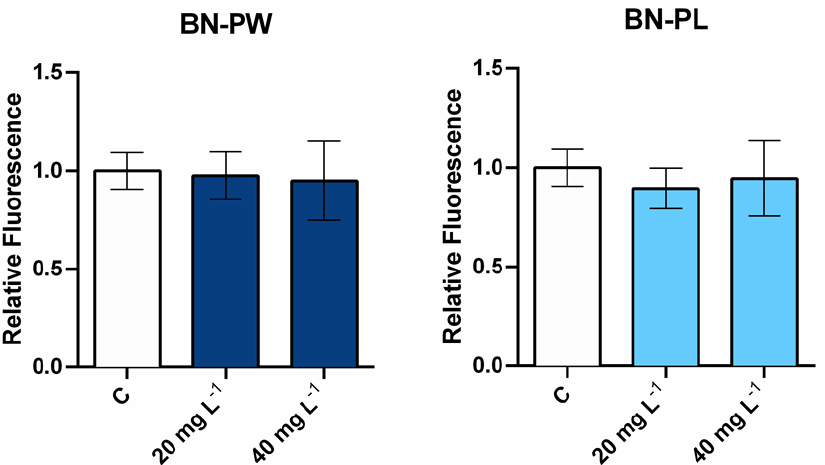
Figure 7. Determination of reactive oxygen species (ROS) levels in A549 cells exposed to 20 and 40 mg/L of BN-PW and BN-PL. “C” corresponds to non-exposed cells. Two independent